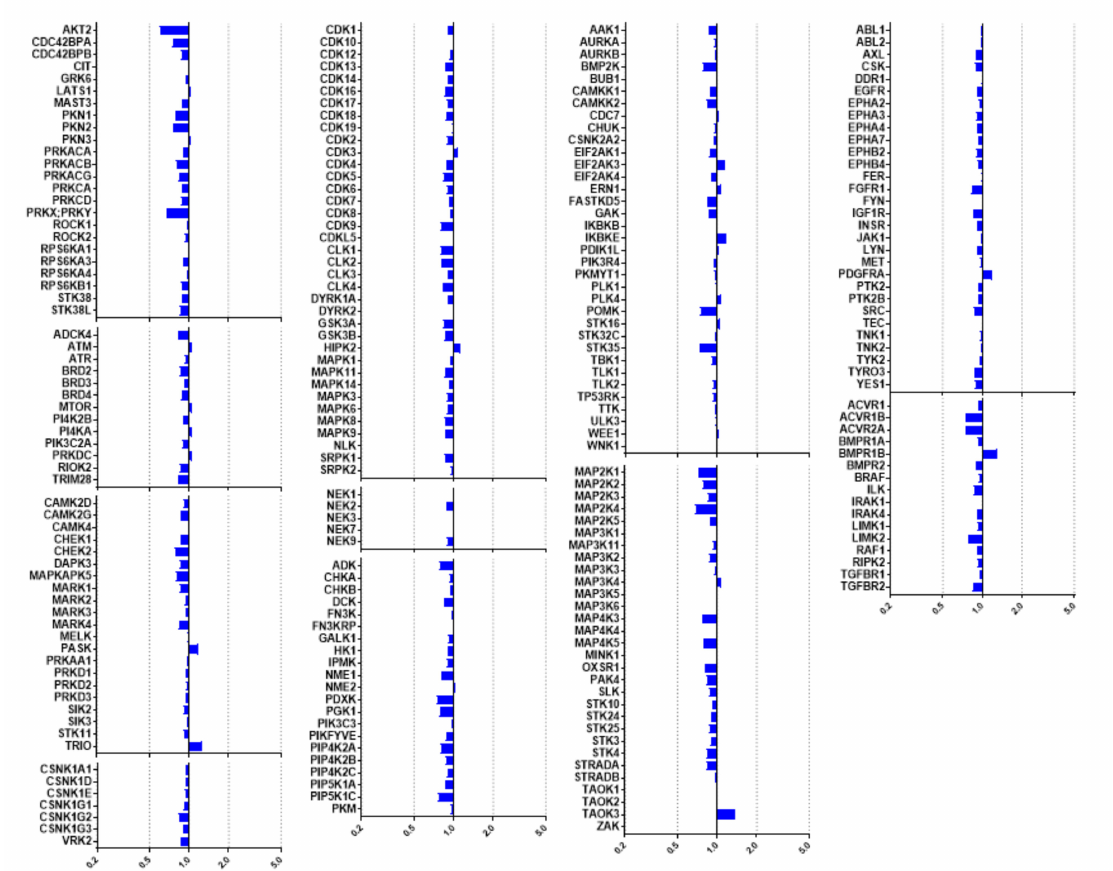
Figure 4. MIBS kinome profiling for thiadiazinone 17 (1 µ